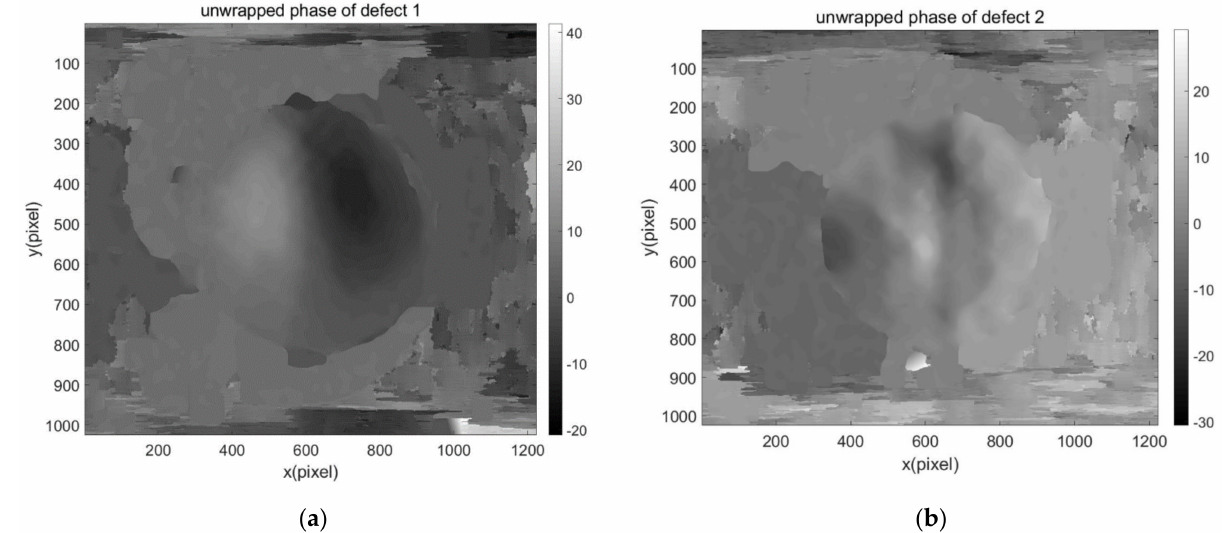
Figure 12. Unwrapped phase maps at ( a ) defect 1 and ( b ) defect 2.